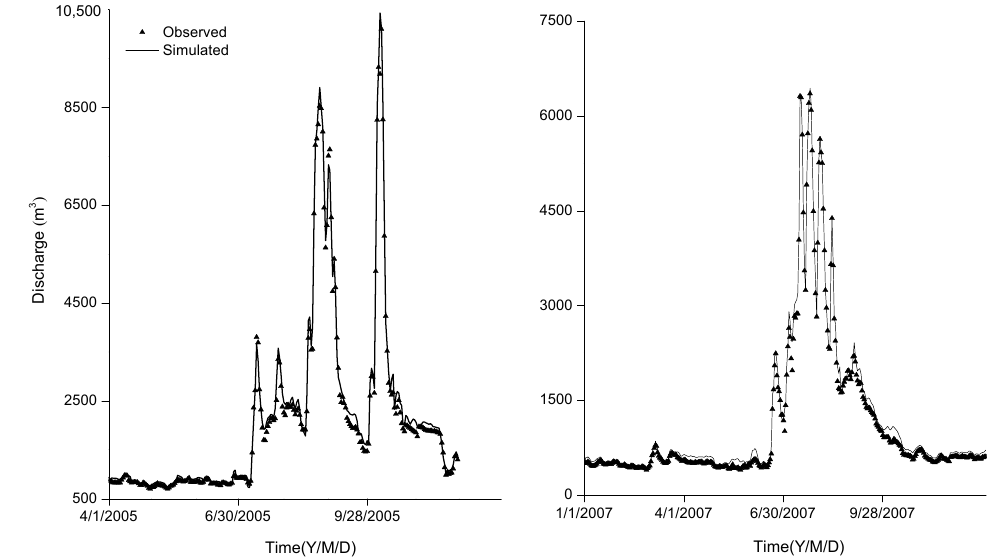
Figure 4. Calibration and validation results of flow processes at the Xiantao station in 2007 and 2005.